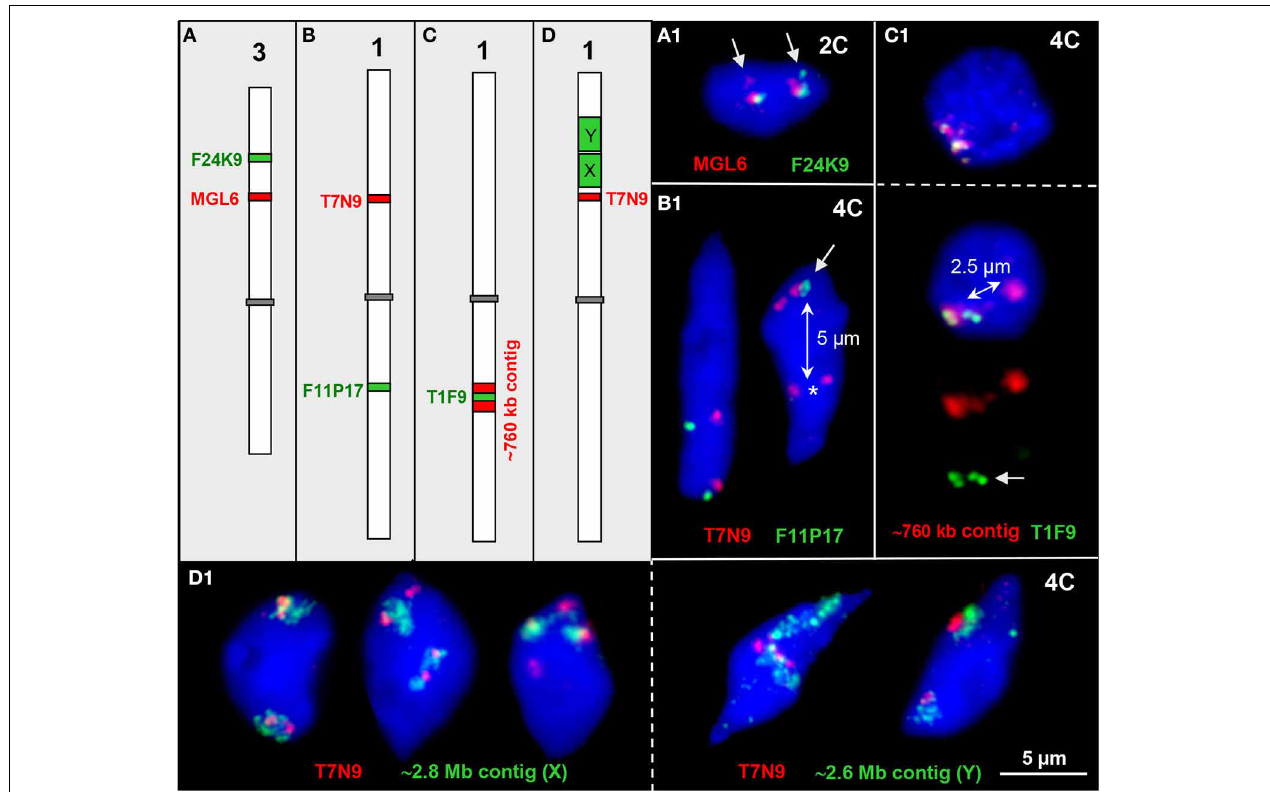
FIGURE 3 | Interstitial chromatin associations. (A–D) Schemes of chromosomes 1 and 3 showing interstitial positions of single BAC and BAC contig inserts in different color as used for FISH. (A1) Parts of both ∼ 100kb euchromatin segments are elongated in one homolog each thus showing a second signal (arrows) in an 2C nucleus. (B1) The ∼ 100kb segments T7N9 and F11P17 located on different arms of chromosome 1 may both be cohesive (left) or one may be separated (right, T7N9) in 4C nuclei. In the right nucleus all four F11P17 sister chromatid segments are cohesive and associated (arrow) indicated by the location apart ( ∼ 5 μ m, double arrow) from the lower located homolog position marked by the two T7N9 signals (asterisk). (C1) The top 4C nucleus contains the 760kb contig of both homologs in close